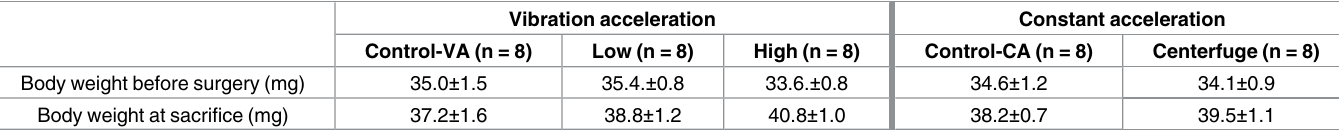
Table 1. Animal body weight in ectopic bone formation